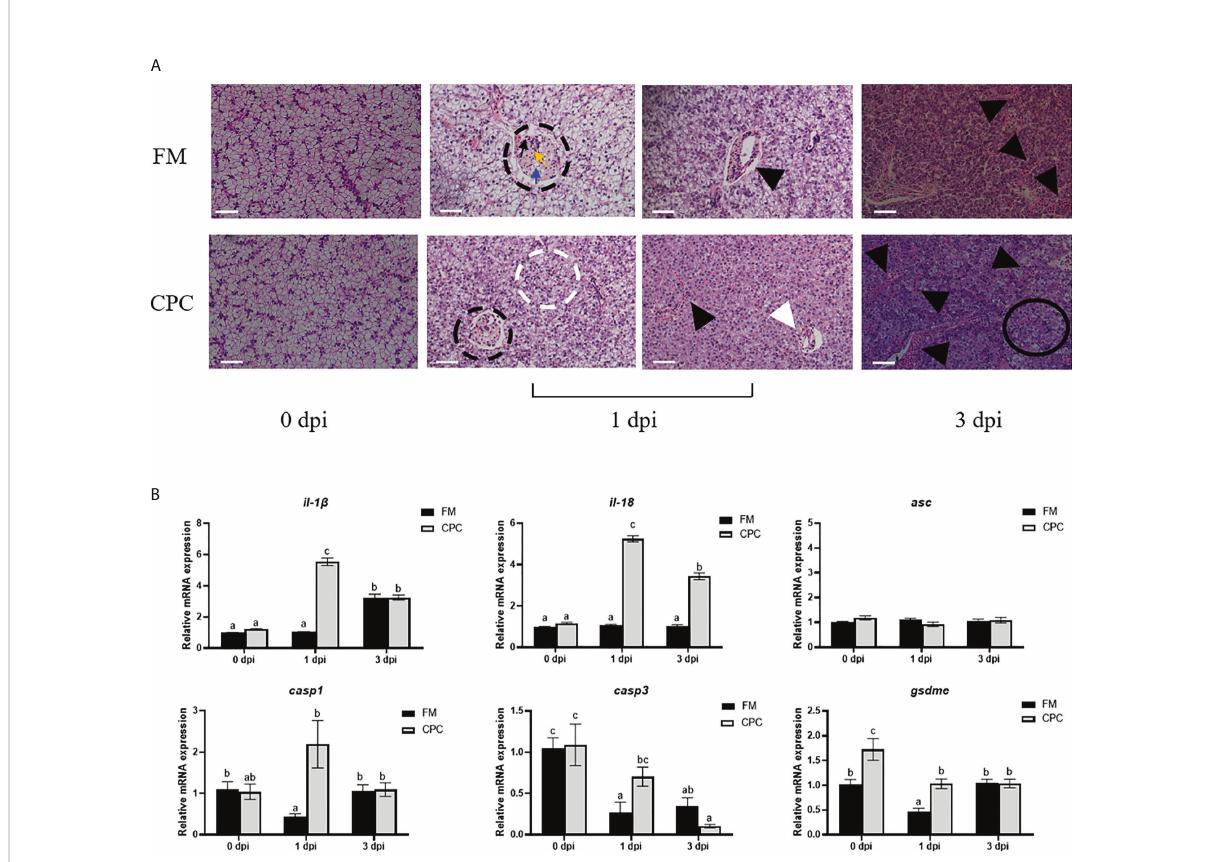
FIGURE 4 Higher in fl ammatory responses were induced in liver of largemouth bass fed with CPC after N. seriolae infection. (A) The H.E. staining results of juvenile largemouth bass liver fed with FM and CPC at different days post N. seriolae infection (dpi). Blue arrows: lipid droplets; black arrows: macrophages; yellow arrows: lymphocytes; black dotted circles: lipogranulomas; white dotted circles: ruptured cell membranes; white triangles: lymphocytic in fi ltration; black triangles: in fl ammatory cells; black circles:cell vacuolar degeneration. Scale bars, 50 m m. (B) The relative mRNA expression levels of genes involved in in fl ammation and pyroptosis ( il-1 b , il-18, asc, casp1, casp3 and gsdme ) in the liver of largemouth bass fed with FM and CPC at different days post N. seriolae infection (dpi). All data was analyzed with two-way ANOVA and data are means ± SD (n = 6). Mean values with different letters indicated signi fi cant difference among groups, P <